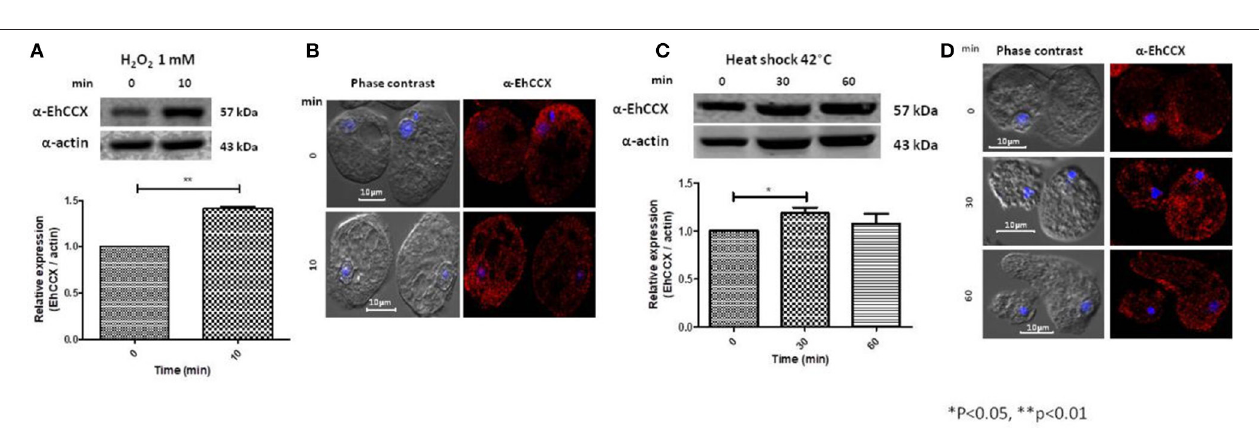
FIGURE 7 | Expression and localization of EhCCX in trophozoites exposed to hydrogen peroxide and to heat shock. (A,B) E. histolytica trophozoites were incubated in the absence (0min) or in the presence of hydrogen peroxide 1mM during 10min. (C,D) E. histolytica trophozoites were incubated at 37 ◦ C (0min) or at 42 ◦ C during 30 and 60min. (A,C) The expression of EhCCX was analyzed by Western blot. As an internal control, the membranes were probed with an α -actin antibody. The band detected by the α -EhCCX antibody was analyzed by densitometry and the data were normalized to the actin content. The relative expression in trophozoites at 0min was taken as 1. Data are expressed as the mean ± standard error of three independent experiments. (B,D) Cells were fixed, permeabilized and incubated with α -EhCCX antibodies. Next, they were incubated with Alexa 555-conjugated secondary antibodies, nuclei were stained with DAPI, and samples were analyzed by confocal